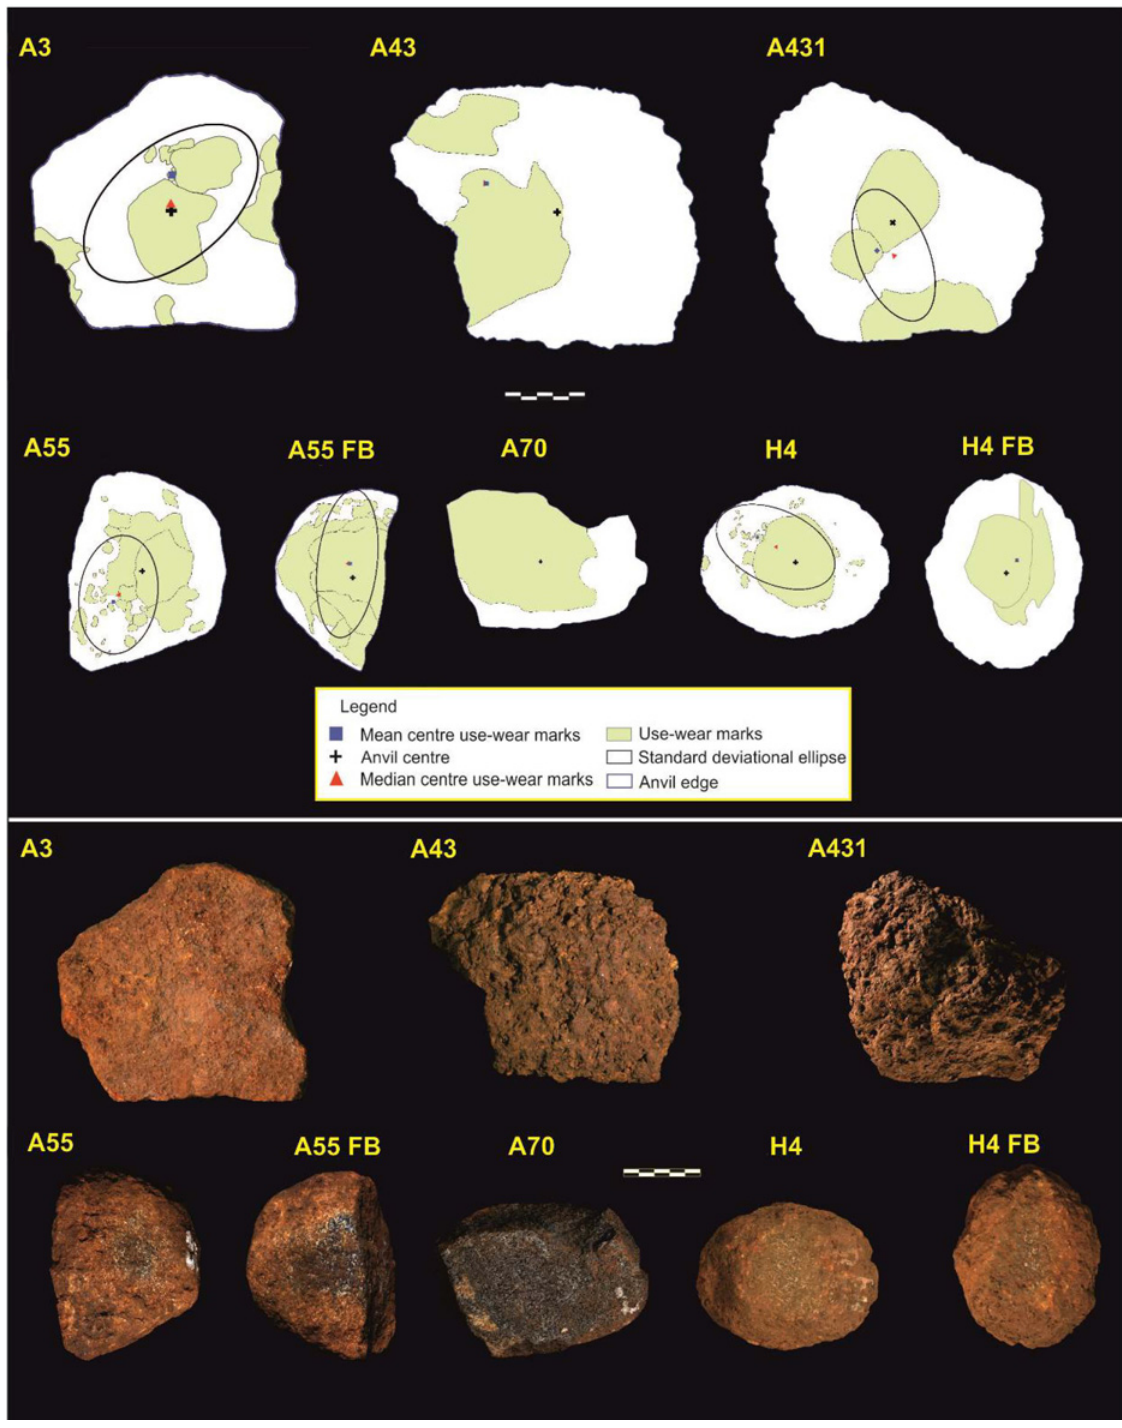
Fig 7. Visual mapping of battering damage in stone tool